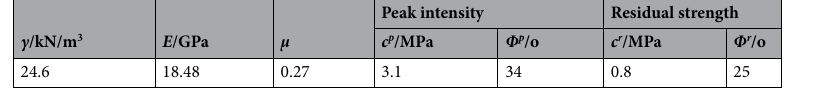
Table 3. Rock mechanical parameters of pull-out test materials. γ : Weight density; c p : Peak cohesive; Φ p : Peak internal friction angle; c r : Residual cohesion; Φ r : Residual internal friction angle.